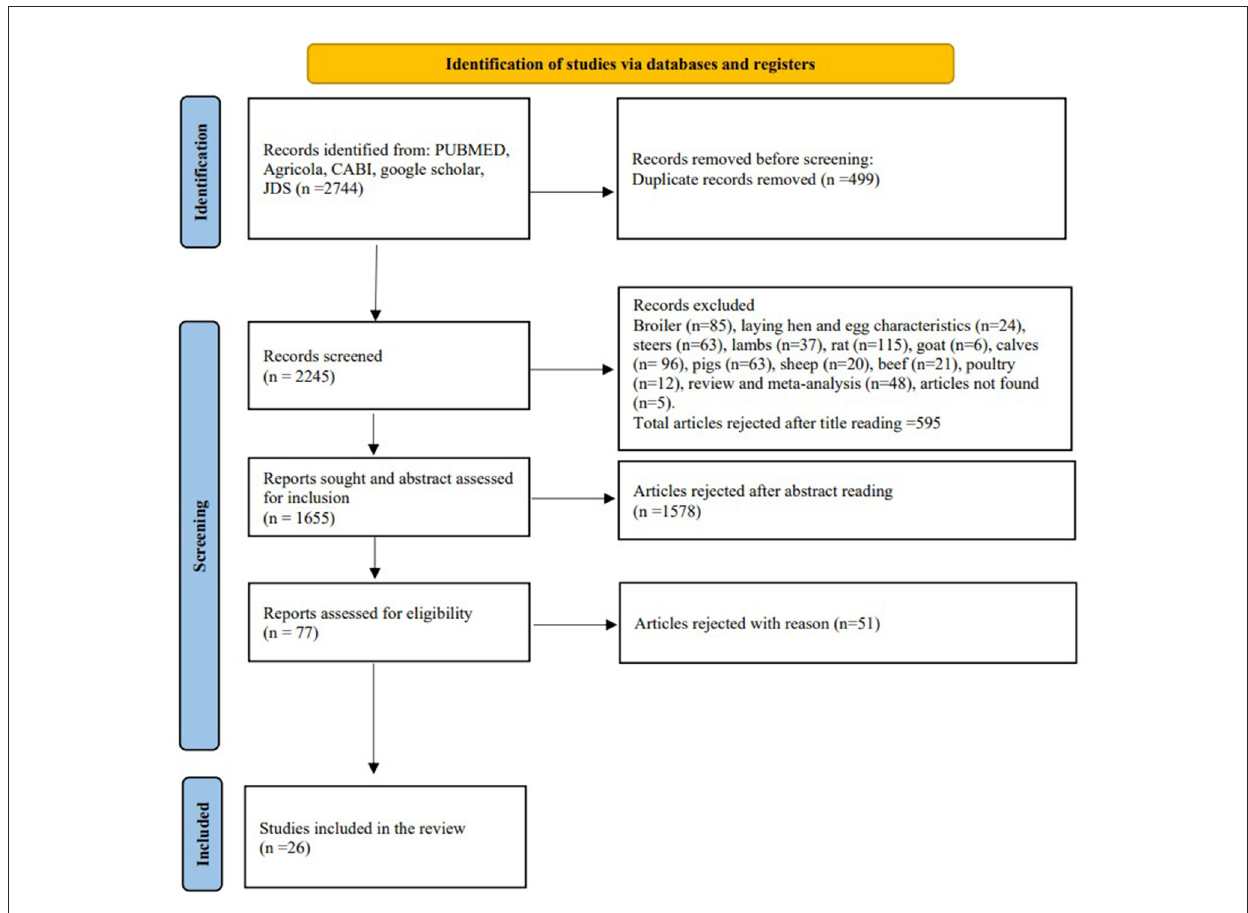
FIGURE1 The flow diagram of search strategies, data screening, exclusion, and inclusion of the studies in